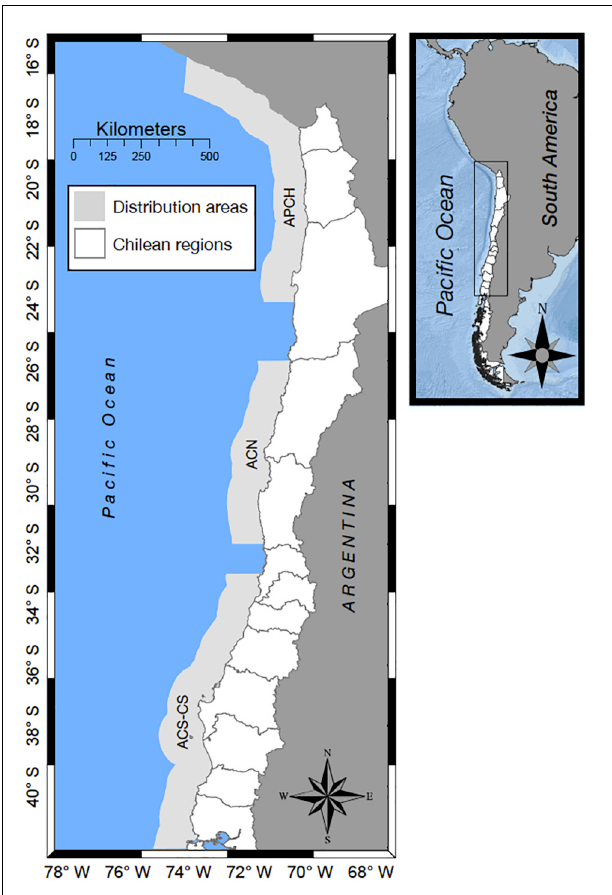
FIGURE 1 | Distribution of the small pelagic fish populations along the Chilean coast and the southern Peruvian coast. The first anchovy population (APCH) is shared between southern Peru and northern Chile (16–24 ◦ LS). The second anchovy population (ACN) is distributed along central-northern Chile (25–32 ◦ LS). The third anchovy population (ACS) and the common sardine (CS) population inhabit the area from 33 to 41 ◦ LS, which is known as central-southern